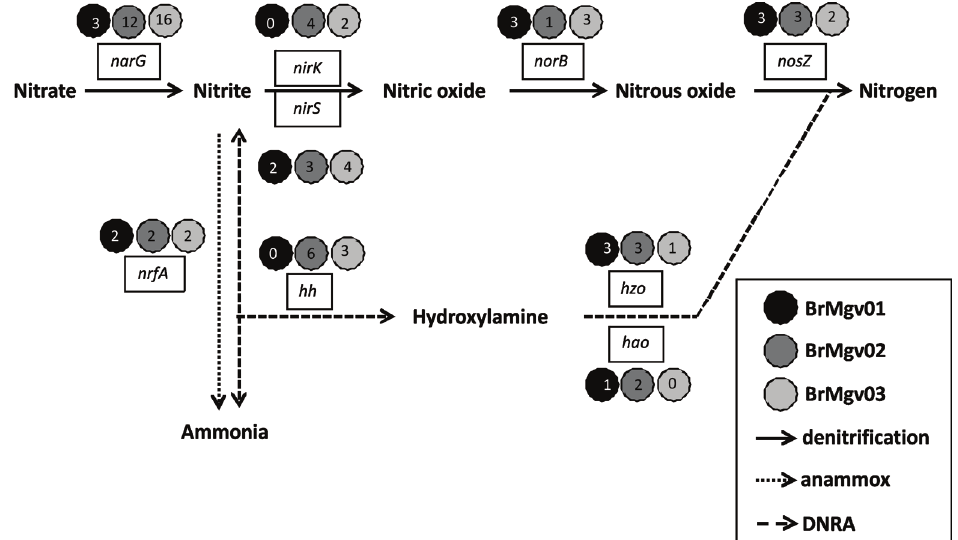
Figure 3 - Functional genes involved in the nitrogen cycle detected in metagenomic reads. the reads selected for this study are involved in denitrification (identified nir K, nos Z , nor B nar G genes, and also considered nir S gene); anammox ( hh , hao and hzo genes) and DNrA ( nrf A), in each mangrove